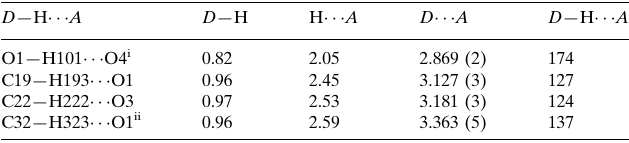
Hydrogen-bond geometry (A˚ , (cid:4)